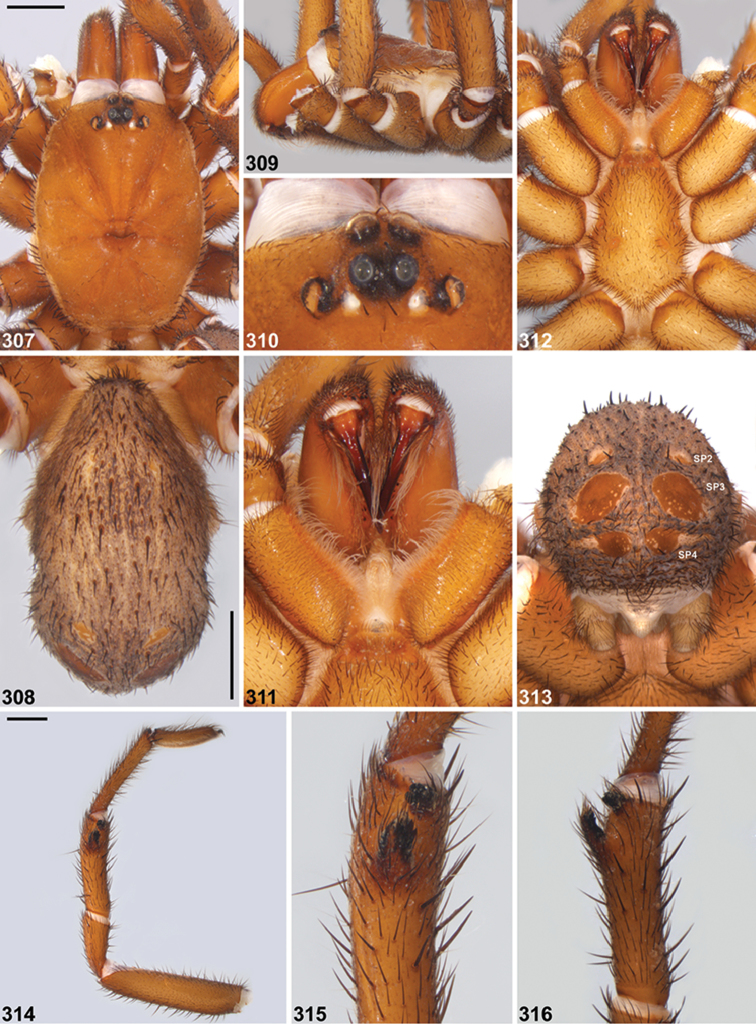

Idiosoma
mcnamarai sp. n., male holotype (WAM T26107) from Trayning (Western Australia; AVW), somatic morphology. 307–308 Carapace and abdomen, dorsal view 309 Carapace, lateral view 310 Eyes, dorsal view 311 Mouthparts, ventral view 312 Sternum, ventral view 313 Abdomen, posterior view 314 Leg I, prolateral view 315 Leg I tibia, clasping spurs, prolateral view 316 Leg I tibia, proventral view. Scale bars 2.0. SP2–4 = sigilla pairs 2–4.